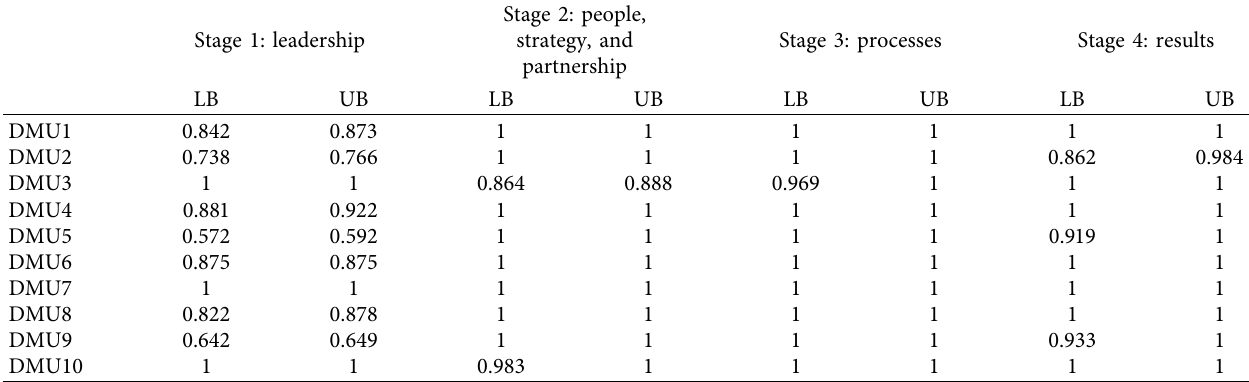
Table 6: The efficiency of EFQM stages at α � 0.5.